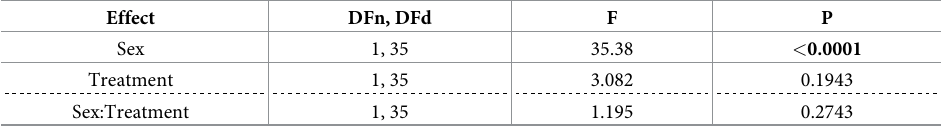
Table 3. ANOVA output of copepodite development time linear mixed effects model.